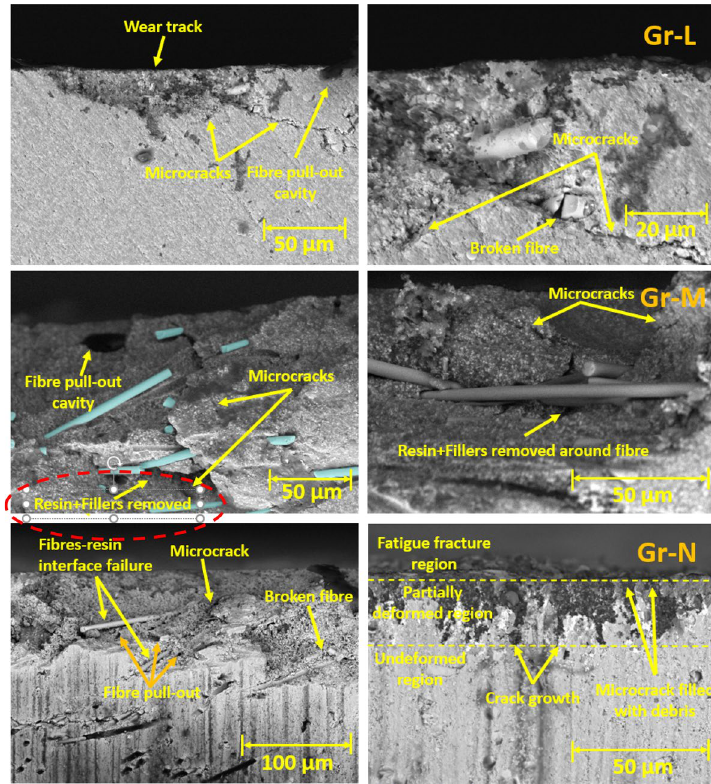
Figure 9. Wear track subsurface SEM images for Rotary Test: 5% 50AR, 5% 70AR and 5% 100 AR.